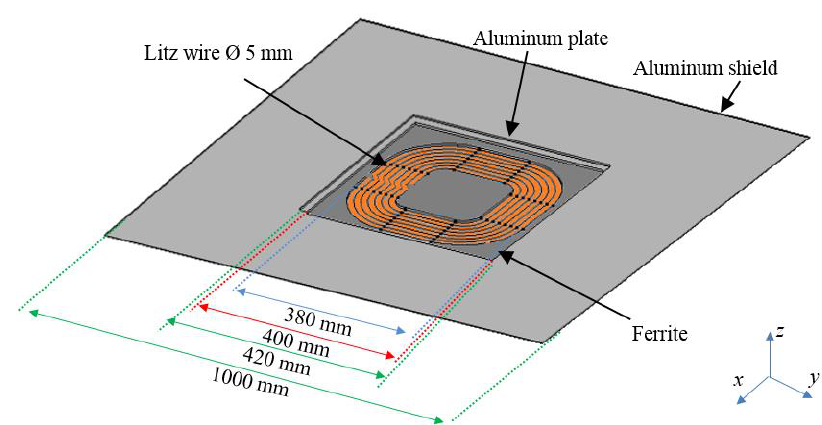
Figure 5. Electro-geometrical configuration of the VA Figure 5 . Electro-geometrical configuration of the VA coil. Figure 5 . Electro-geometrical configuration of the VA coil. Table 1. Electro-geometrical configuration of the considered WPT coils. Table 1. Electro-geometrical configuration of the considered WPT coils.